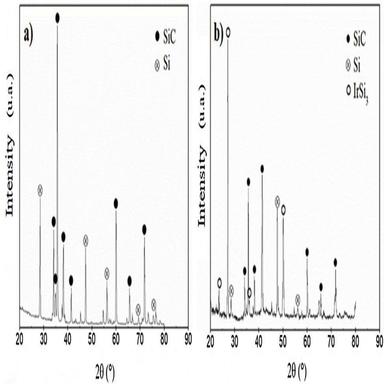
X-ray diffraction patterns of composite materials: a) SiC/Si produced at T = 1450 °C and b) SiC/IrSi3 produced at T = 1350 °C.